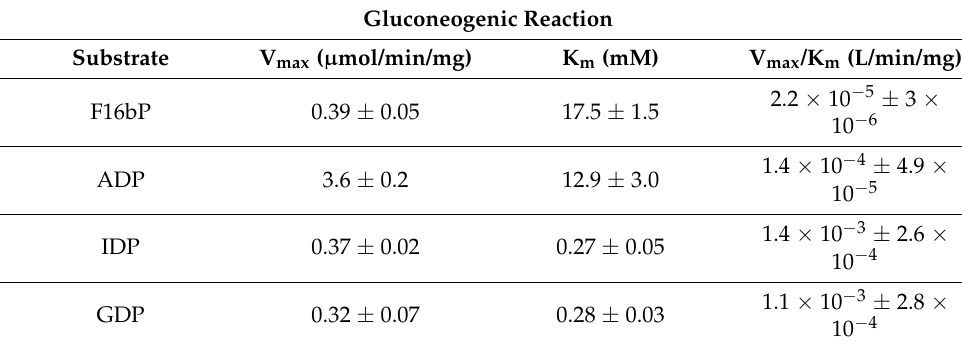
Figure 2. Gluconeogenic activity of Pfk B. ( A ) Dependence of Pfk B activity on the concentration of fructose-1,6-bisphosphate (F16bP). The concentration of ADP was kept at 1 mM while the concentration of F16bP was varied between 0–50 mM. ( B ) Dependence of Pfk B activity on the concentration of nucleoside diphosphates (NDPs). The concentration of F16bP was kept at 5 mM while the concentration of NDP was varied between 0–20 mM. Error bars are standard deviations from three independent experiments. The data in panel ( A ) and ( B ) were fitted to Equations (1) and (4). Table 2. Kinetic characteristics of Pfk B in the gluconeogenic reaction.